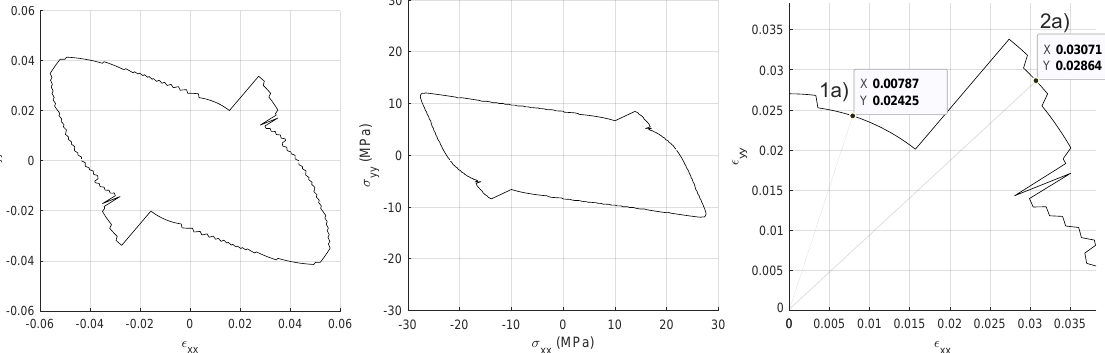
Figure 6. Failure envelopes with crack stifness G = 10 14 Pa. von Misses energy criterion: strains ( left ), stresses ( center ). Coordinates in the strain plane to extract configurations of failure region 1 a and 2 a . ( right